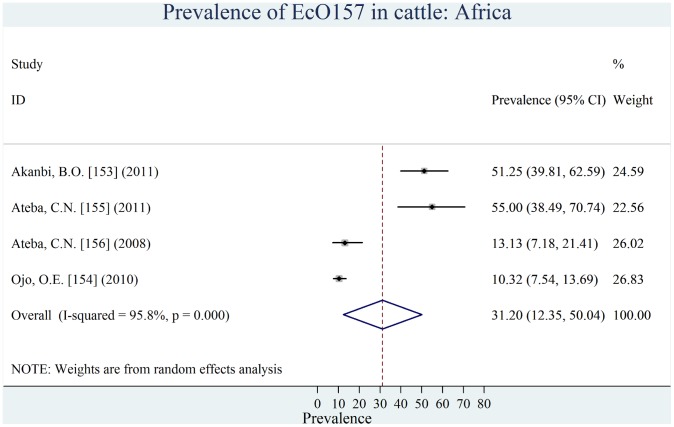
Forest plot of prevalence of E. coli O157 in cattle amongst studies conducted in Africa.(In all forest plots, the gray square around the dot represents the contribution of each study (weight) to the meta-analysis and the center dot represents point estimate).